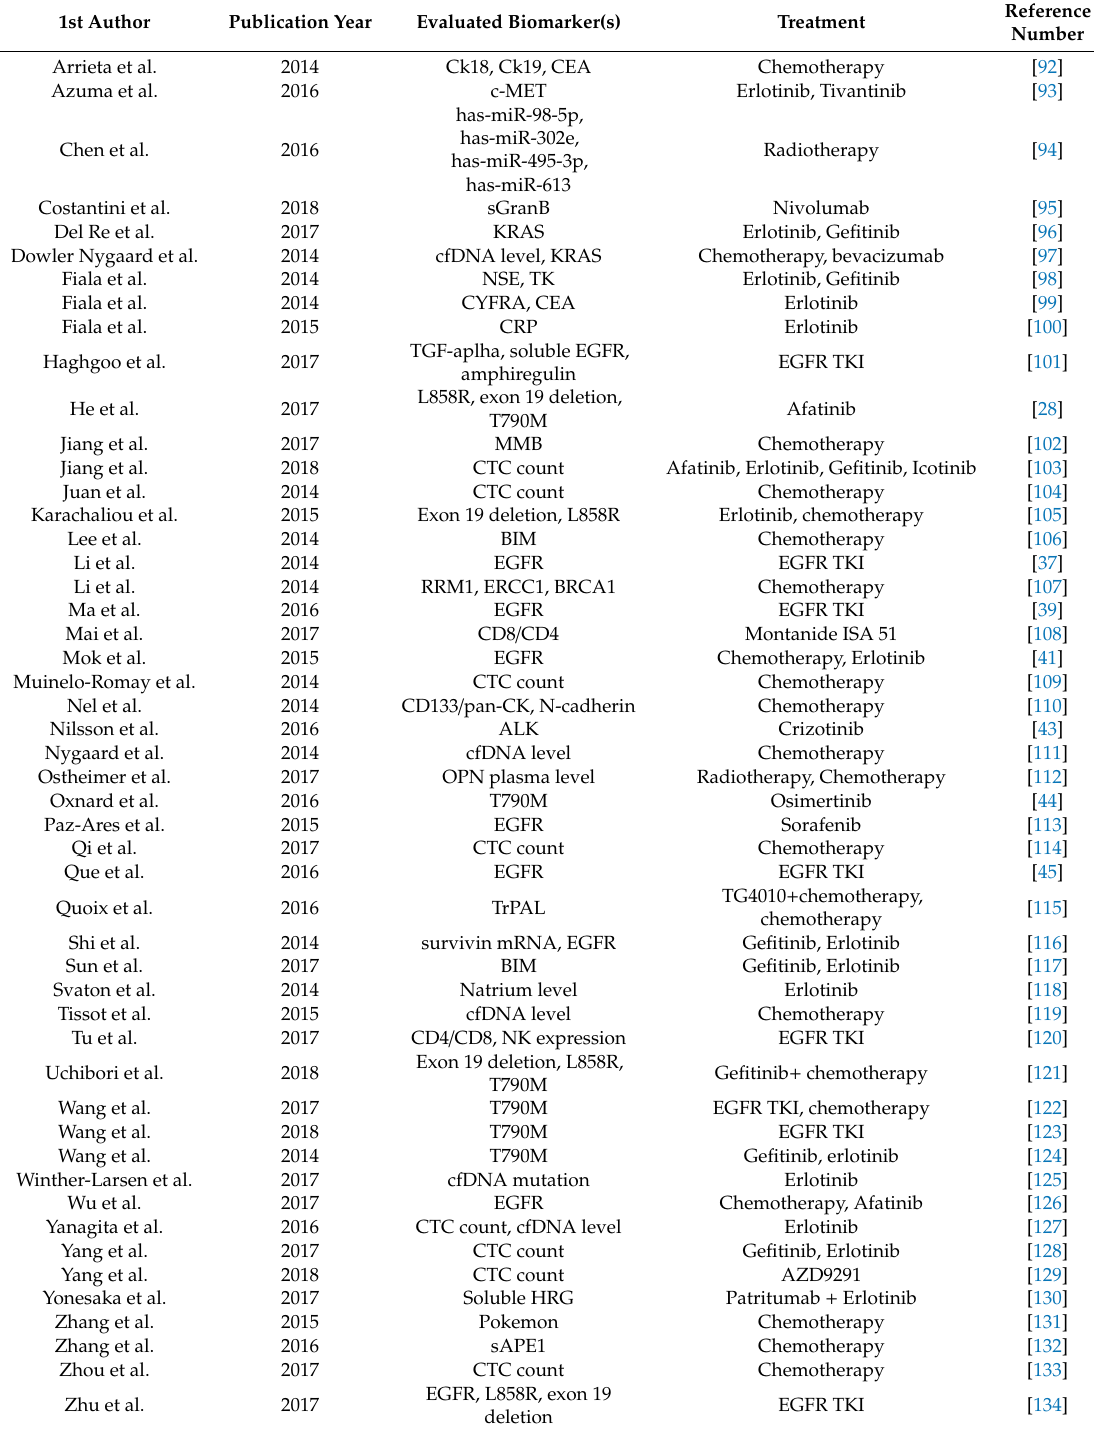
Table 2. Description of included studies describing the predictive value of a liquid biopsy-based